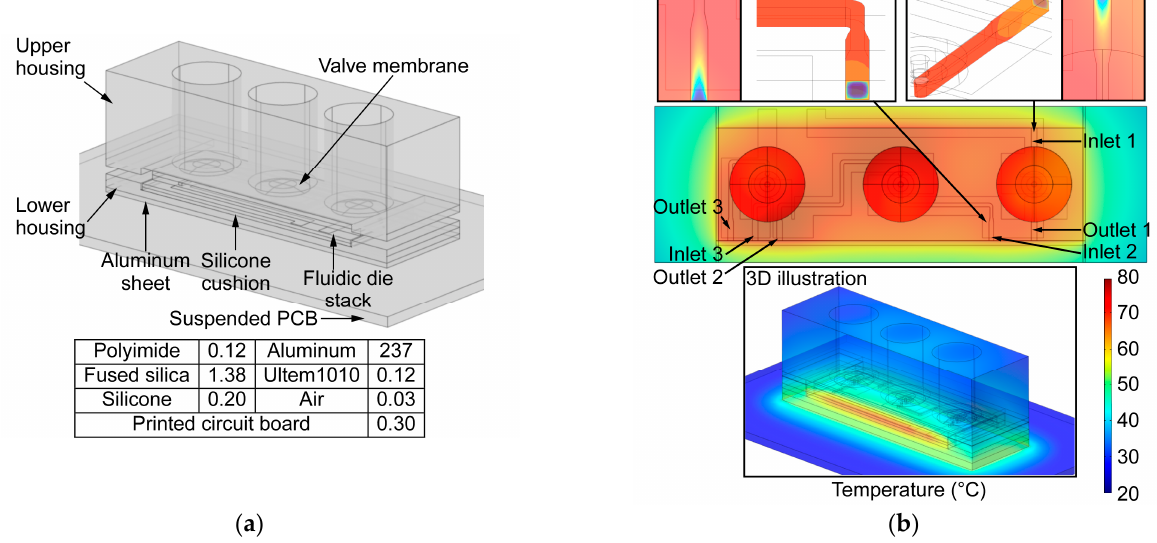
Figure 7. ( a ) The geometric model and the thermal conductivity values (Wm − 1 K − 1 ) used in the simulation. ( b ) The temperature distribution of fluidic die stack with a simulated heater power of 1.1 W. Close-up views of the valve inlets are shown in the insets.